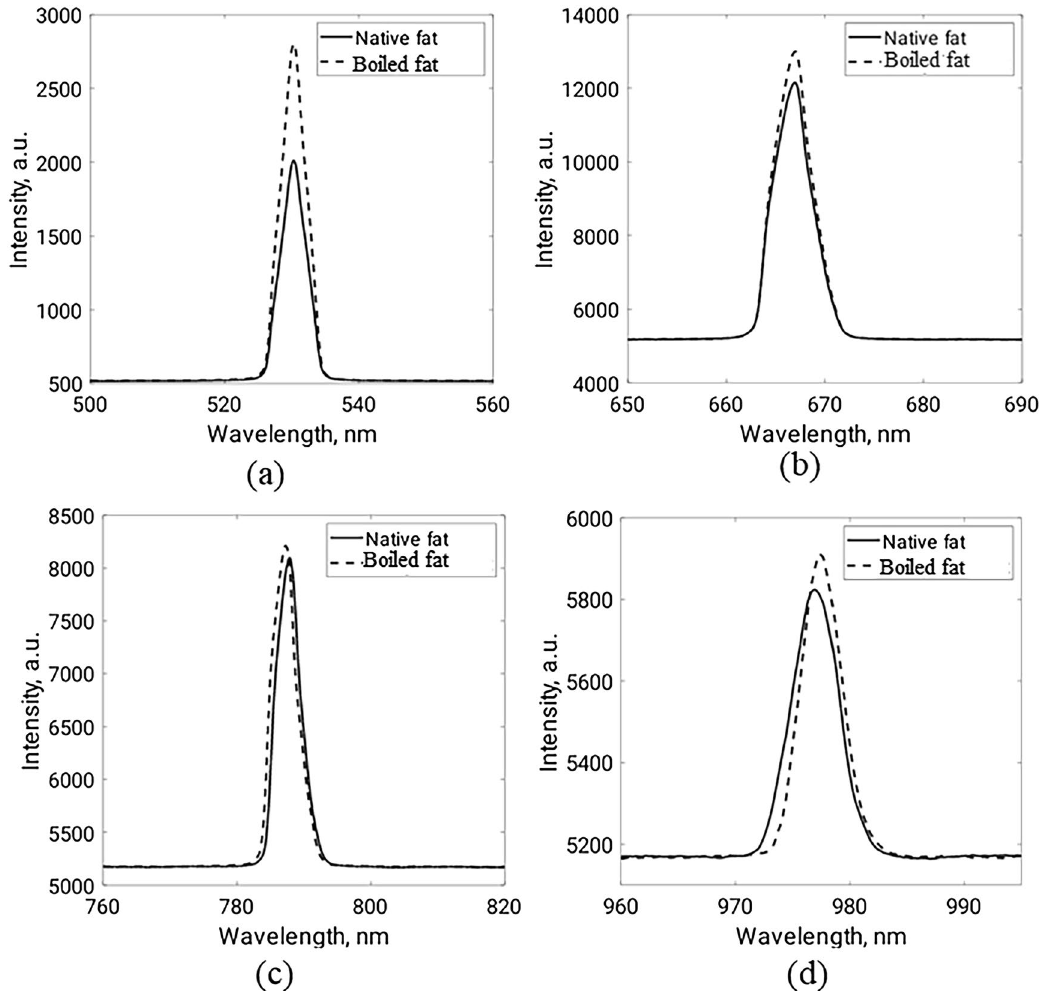
Figure 13. Diffuse reflected light of fat samples at ( a ) 532 nm, ( b ) 660 nm, ( c ) 780 nm, and ( d ) 980